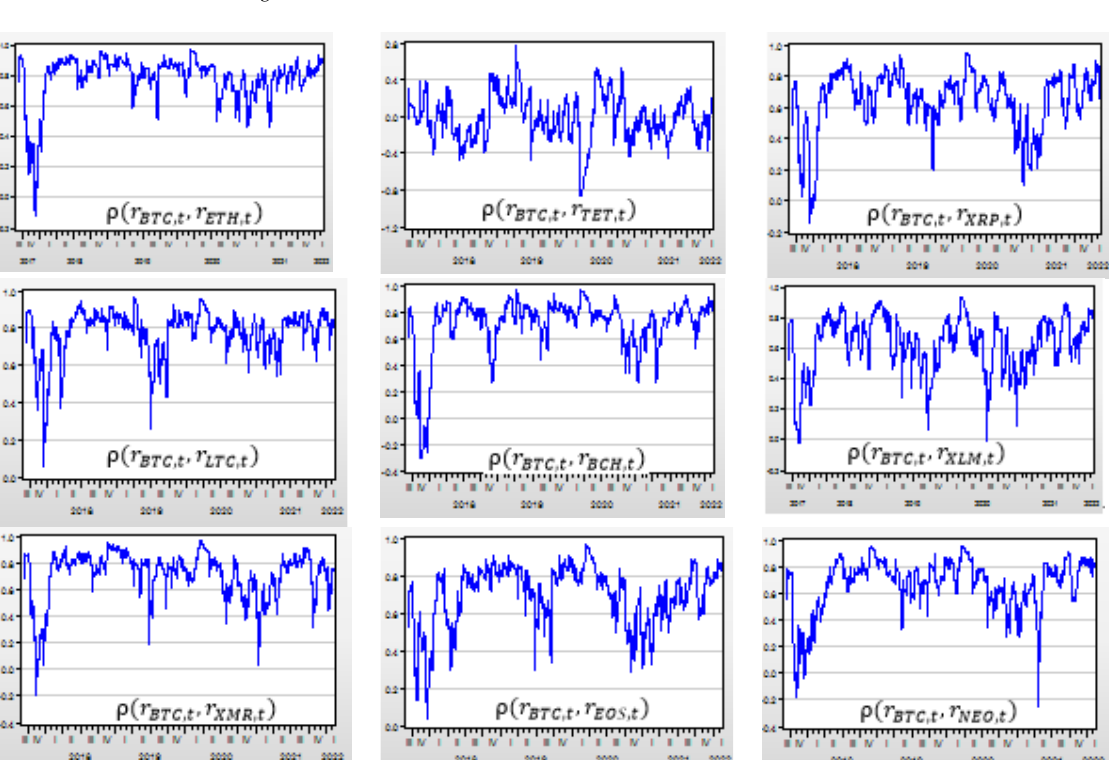
Figure 3. Curves of DCC between Bitcoin and the other nine cryptocurrencies for the full period. During the full period, except for Tether, the average varying correlations between the return indices of Bitcoin and the other cryptocurrencies, including Ripple, Litecoin, Bitcoin Cash, Stellar, Monero, EOS, and NEO, were 0.63941, 0.773738, 0.699301, 0.624351, 0.708394, 0.690766, and 0.658295, respectively; otherwise, the average varying correlations between the return indices of Ethereum and the other cryptocurrencies, including Ripple,